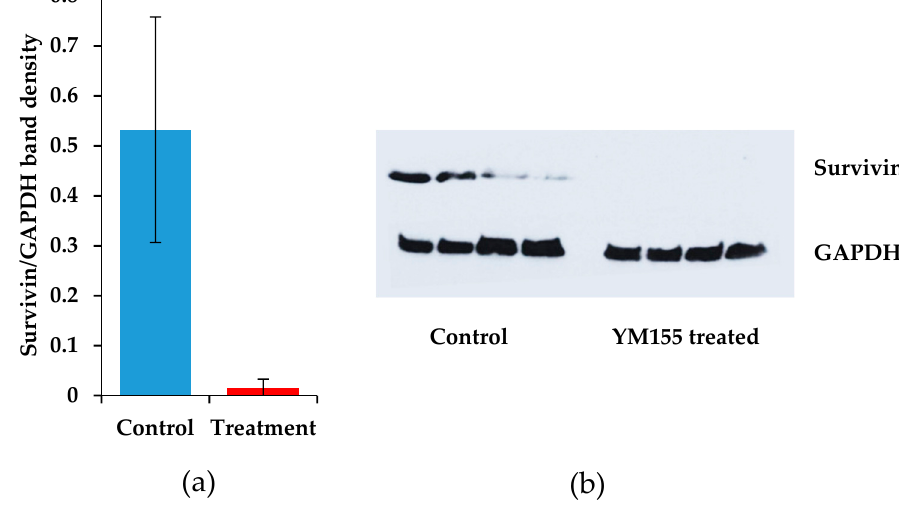
Figure 5. YM155 decreases survivin in mouse synovial sarcomas. ( a ) Survivin expression was immunoblotted and band density was measured. Survivin expression was normalized to GAPDH protein levels, bars represent the SEM, n = 4; ( b ) Immunoblots of survivin (top) and GAPDH (bottom) in control and YM155 treated mice after 11 days.